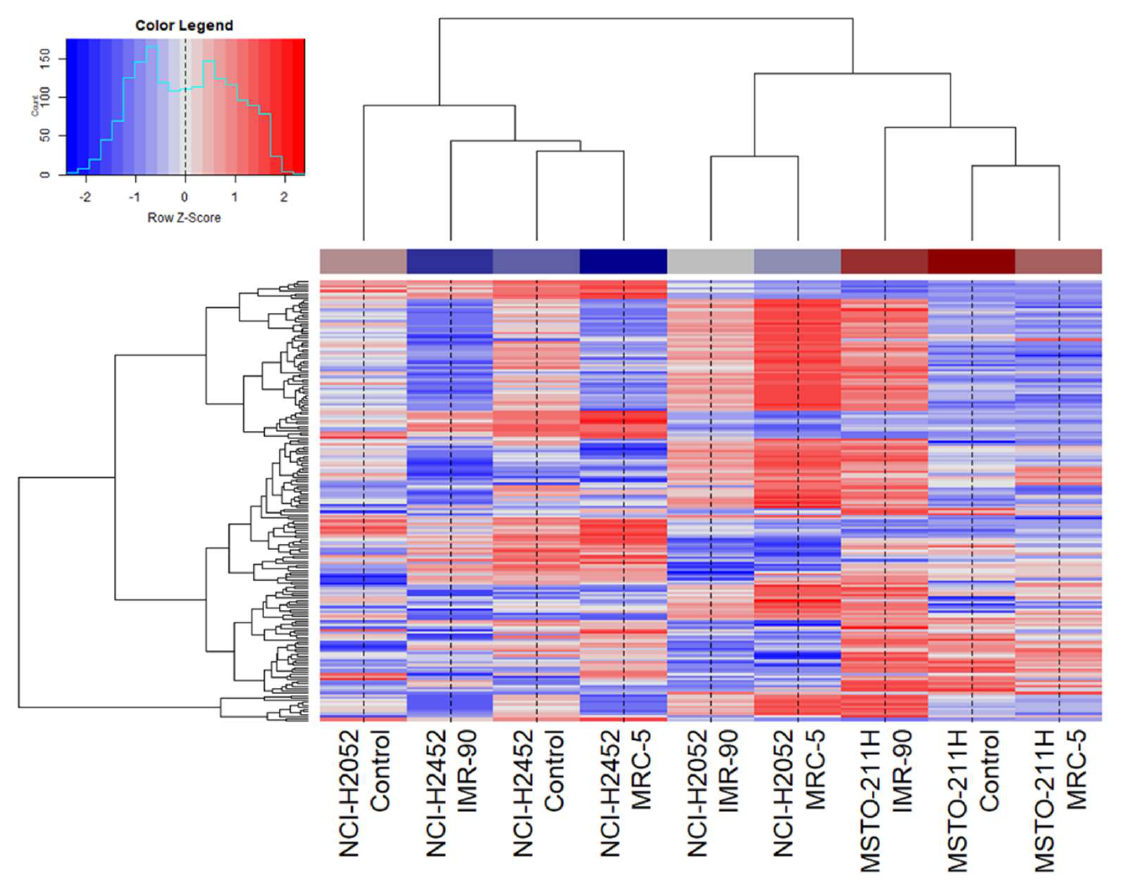
Figure 1. Unsupervised clustering of treated cell lines and controls. MPM cell lines (NCI−H2052, NCI−H2452, and MSTO−211H) were treated with conditioned medium of fibroblast cell lines IMR- 90 or MRC-5. In controls, conditioned medium of the respective MPM cell line itself was used. 1.2. Viability, Apoptosis, and Invasiveness of MPM Cells Treated with FB Derived CM First Bullet